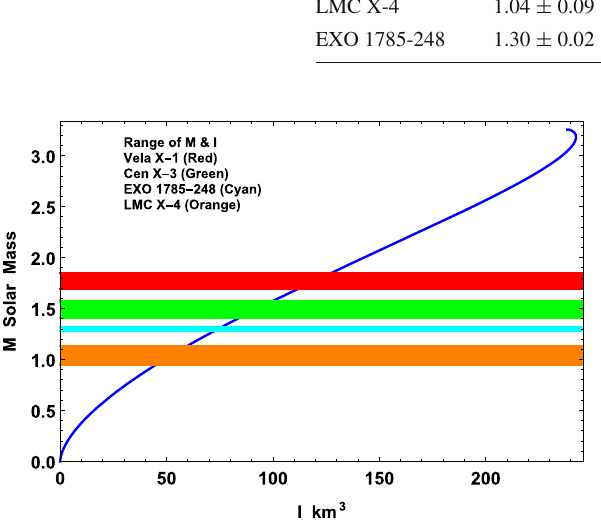
Table 1 Masses and radii of the four celestial compact stars with their approximate moment of inertia